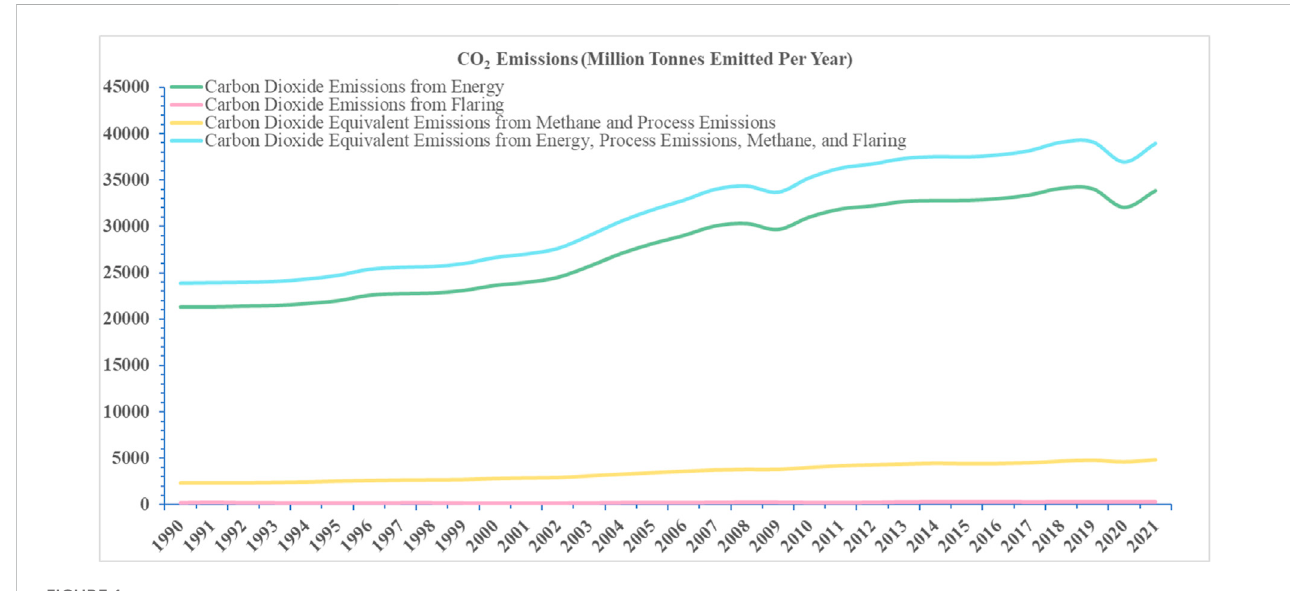
FIGURE 1 CO 2 emissions emitted all over the world from year 1990 to